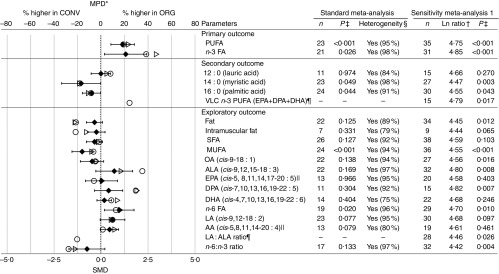
Results of the standard weighted meta-analysis and sensitivity analysis 1 for fat
composition of meat (data for all animal groups included in the same analysis). *
Numerical values for mean percentage difference (MPD) and 95 % CI are given in the
online Supplementary Table S9. † Ln ratio=ln (ORG/CONV×100 %). ‡ P
value<0·05 indicates a significant difference between organic samples (ORG)
and conventional samples (CONV). § Heterogeneity and the I
2 statistic. || Outlying data points (where the MPD between ORG and CONV
was more than fifty times greater than the mean value including the outliers) were
removed. ¶ Calculated based on published fatty acids (FA) composition data.
n, number of data points included in meta-analyses; VLC
n-3 PUFA, very long-chain n-3 PUFA; DPA,
docosapentaenoic acid; OA, oleic acid; ALA, α-linolenic acid; LA,
linoleic acid; AA, arachidonic acid; SMD, standardised mean difference; ○, MPD
calculated using data included in standard unweighted meta-analyses; ▷, MPD
calculated using data include in standard weighted meta-analysis; ◆, SMD with 95 %
CI represented by horizontal bars.